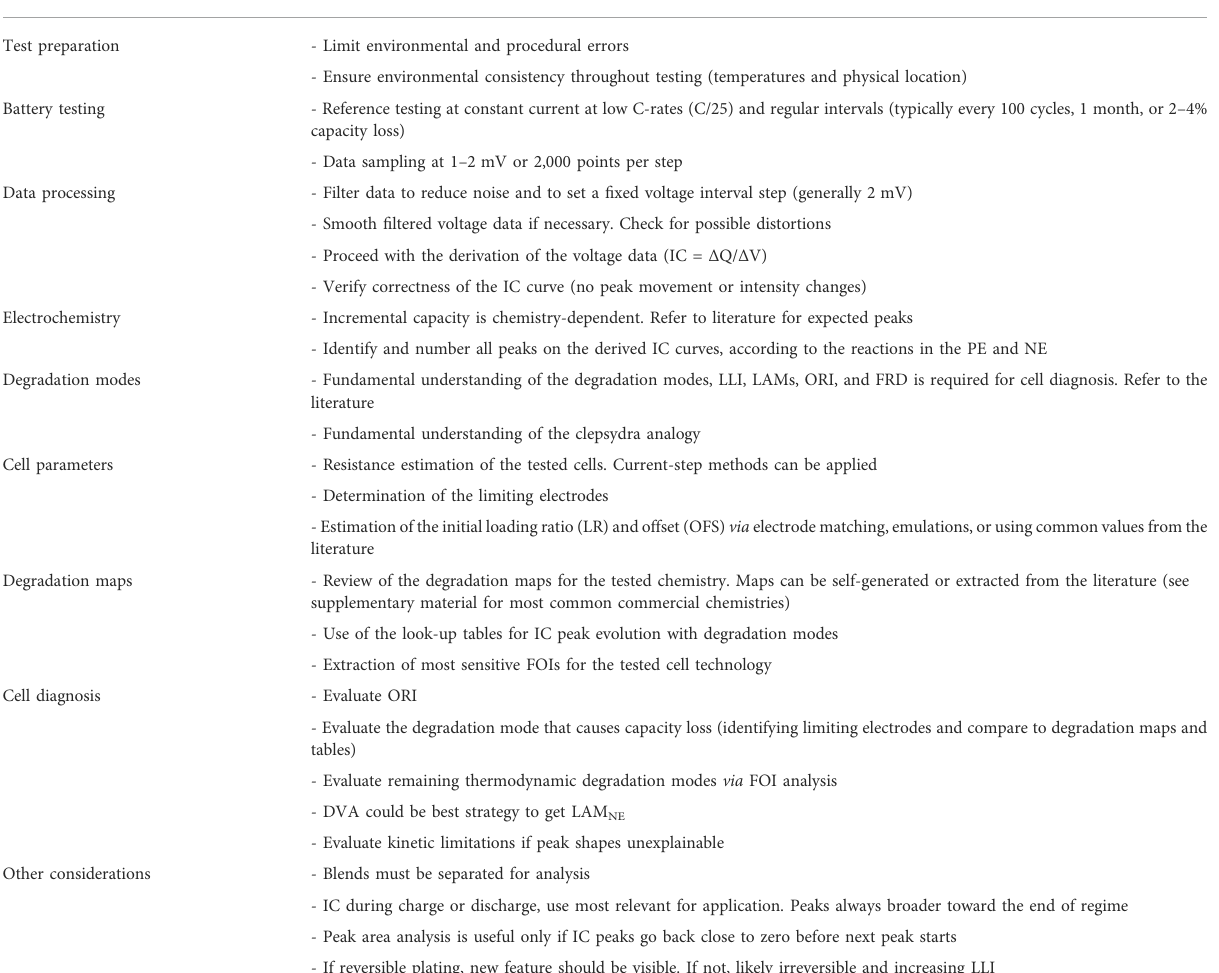
TABLE 2 Best practices for incremental capacity